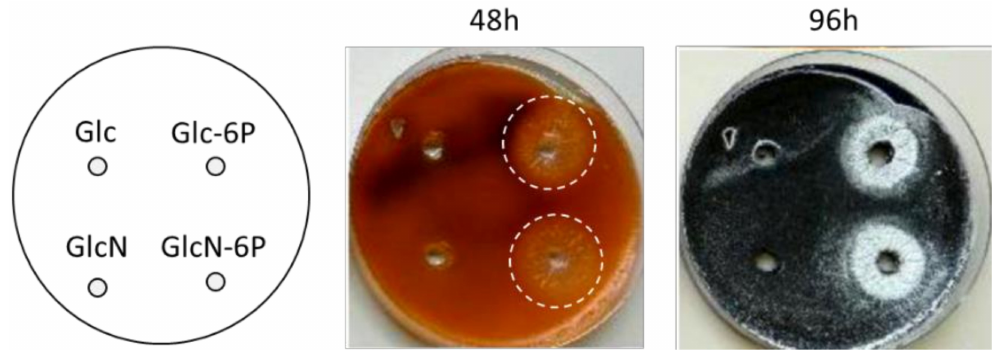
Figure 3. Sugar phosphates reduce PdG production and accelerate sporulation of S. coelicolor . A suspension containing 10 7 viable spores of S. coelicolor M145 was plated on R2YE solid medium. After 20 h of growth, wells (5 mm diameter) were made into the agar and 100 mM of glucosamine (GlcN), glucose (Glc), glucosamine-6-phosphate (GlcN-6P), and glucose-6-phosphate (Glc-6P) were deposited into them. Dotted circles highlight the zone around the source of phosphorylated sugars with reduced PdG production. Note how zones with reduced production of PdGs at 48 h coincides with the zones with precocious erection of aerial hyphae at 96 h.